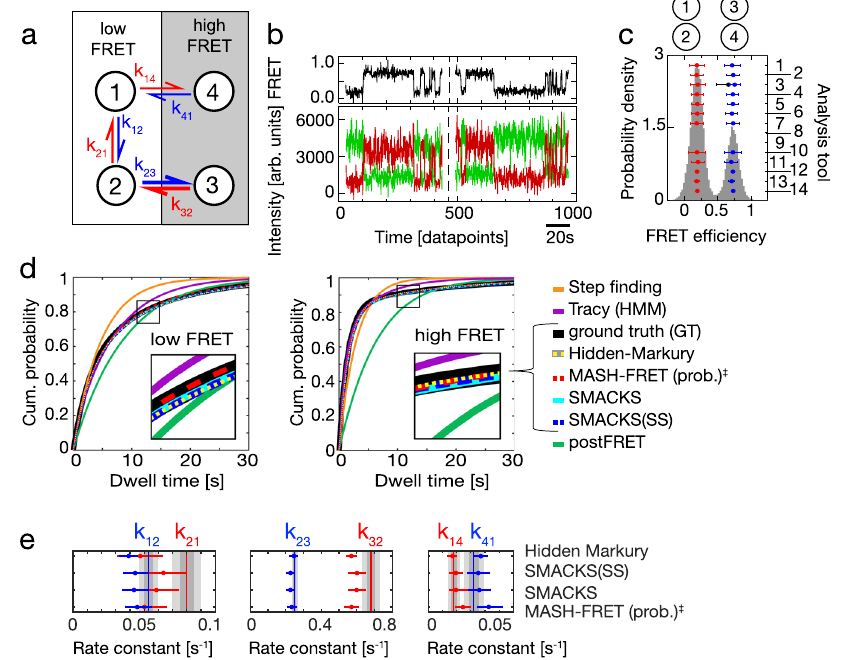
Fig. 4 | Resolving kinetic heterogeneity: states with indistinguishable FRET ef fi cienciesbutdifferentkinetics.a AnillustrationofthesimulatedGTmodelwith states (circles) connected by forward and reverse rate constants. States 1 and 4 as well as states 2 and 3 have indistinguishable FRET ef fi ciencies, causing kinetic heterogeneity. b TwosimulatedFRETtracesoffsetintimewithdonorandacceptor fl uorescence intensity (green, red) and FRET ef fi ciency (FRET, black) are shown, representativeforthedatasetusedin( c , d ):n(traces)=250,n(datapoints)=56,794, sampling rate=5Hz, time per datapoint=200ms. c FRET histogram with inferred FRETef fi cienciesoverlaid(rightaxis:legendasinTable1andinallFigures).Sample size as in ( b ). The error bars represent standard deviations. d Comparison of cumulativedwelltimedistributionsderivedfromthekineticmodelswithtwoFRET states (detailedinMethods).TheGThistogramisshownas aboldblackline.Insets show zoomed-in views of the data indicated by the squares. e Quantitative